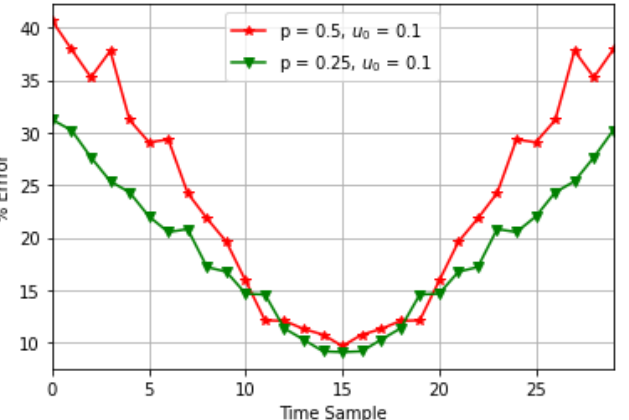
Figure 12. Average % error for an image with applied Poisson noise to CS measurements for a single-lensed microlensing event with µ 0 = 0.1 using binomial measurement matrix with p = 0.5 and p =